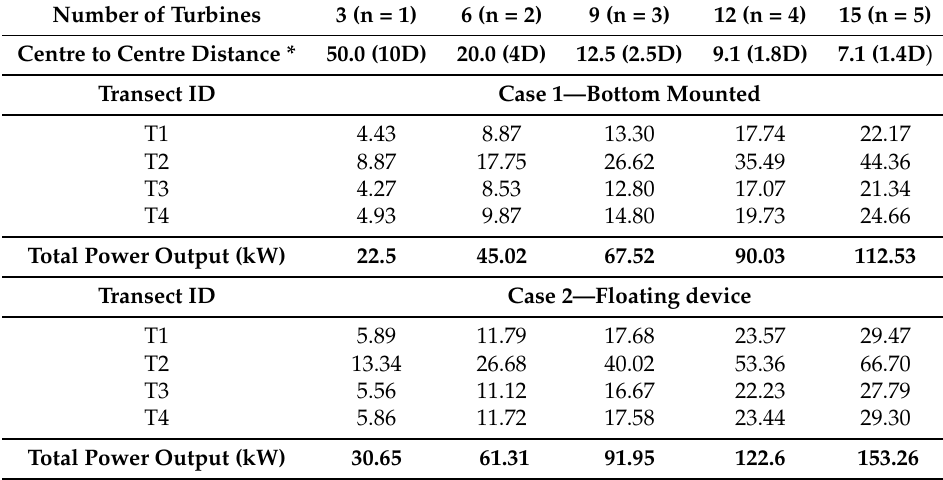
Table 4. Power output for Transects T1–T4 relative to the number of turbines placed for each case